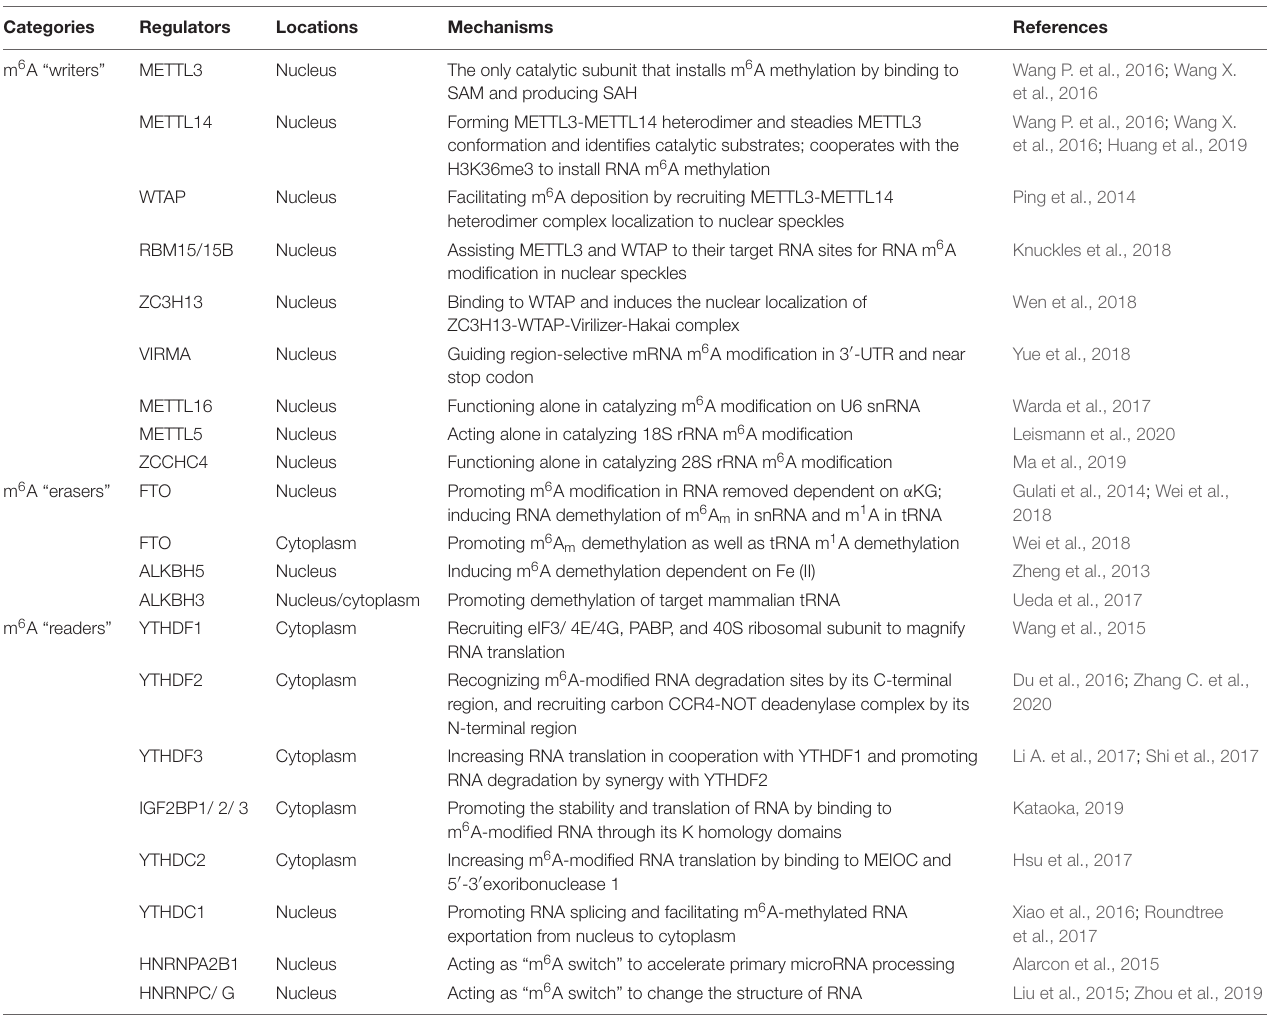
TABLE 1 | The locations and mechanisms of RNA m6A modification